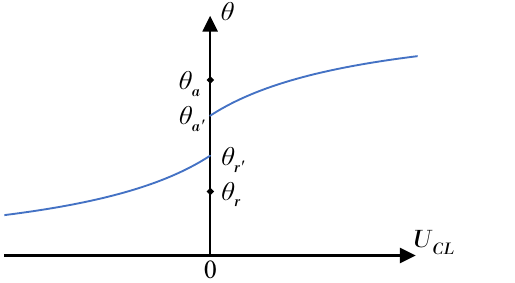
Fig. 1 Traditional diagram for contact-line behavior. Dynamic contact angle θ dependence on contact-line speed U CL with θ a and θ r the static advancing and receding contact angles, respectively.